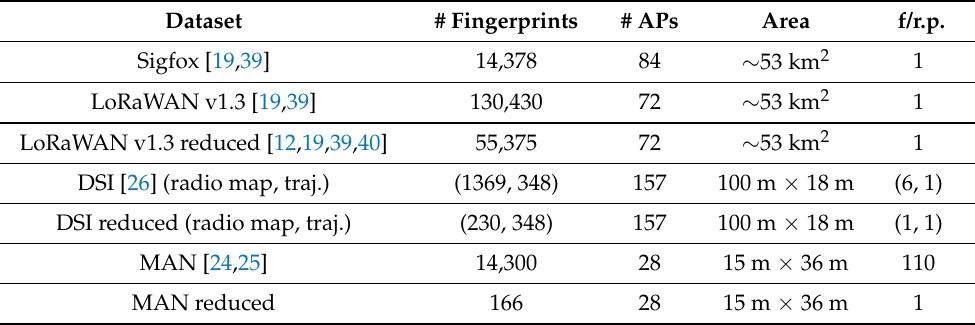
Table 3. Features of the selected datasets. The columns report the amount of fingerprints, the number of Access Points (APs), the size of the area where fingerprints where collected, and the number of fingerprints per reference (or measurement)